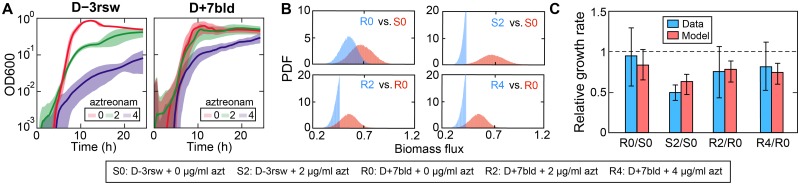
Validation of metabolic model using experimental growth data.(A) Experimental growth curves of both sensitive (D-3rsw) and resistant (D+7bld) P. aeruginosa strains at various aztreonam concentrations (μg/mL). (B) Steady state distribution of biomass flux predicted from metabolic models for the same experimental conditions (except for D-3rsw at 4μg/mL aztreonam). PDF: probability density function. (C) Comparison of the measured growth rate (blue bars) with the model predictions (red bars). The measured growth rates were obtained by fitting an exponential growth model to the exponential phase of the growth curves shown in (A). The predicted growth rates were approximated from the mean of the biomass flux distributions shown in (B). The growth rates are relative to that of the sensitive strain in the absence of aztreonam (S0). Error bars: standard deviation.